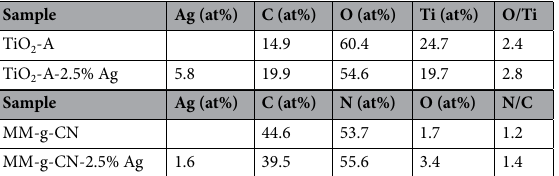
Table 8. The elemental composition of the samples revealed by XPS measurement.